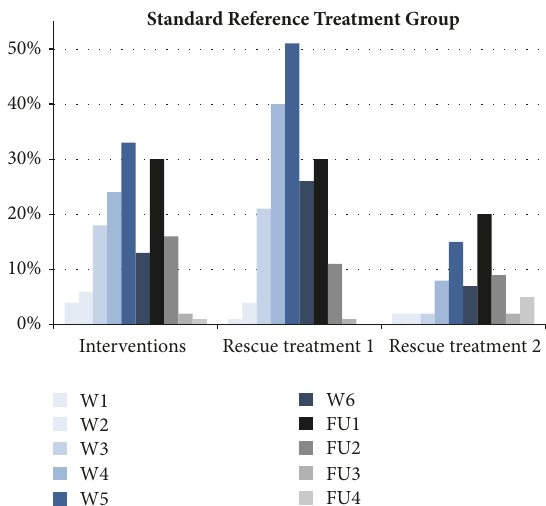
Figure 4: Interventions (wound smears and compresses) and rescue treatment 1 (Ialugen cream) and rescue treatment 2 (Ialugen plus cream) in the standard care reference treatment group. The denominatoris countof patients in the regarding population (CSNF group: n=20; standard reference treatment group: n=100). W: week; FU: